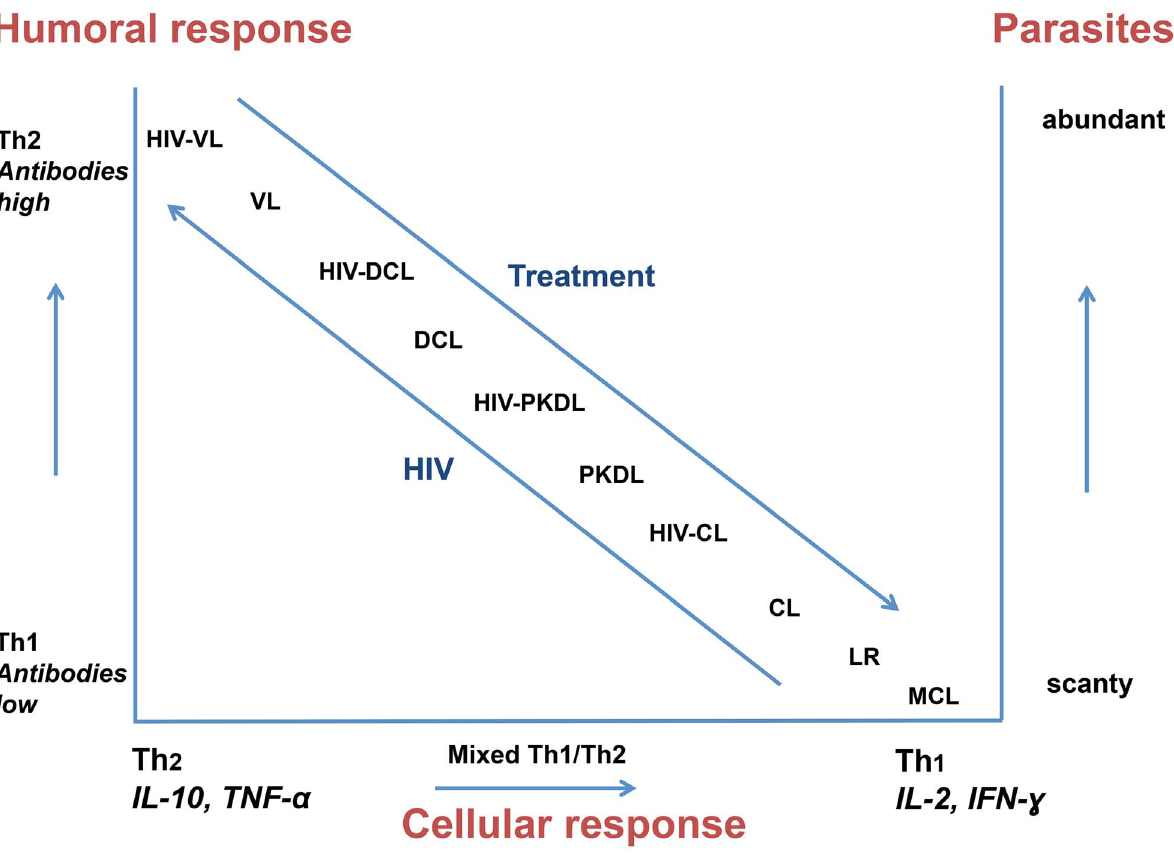
Figure 2. A simplified, theoretical presentation of the relationship between Th1 and Th2 responses, and parasite load, with the influence of HIV and antileishmanial and antiretroviral treatment on cutaneous leishmaniasis (CL), post-kala-azar dermal leishmaniasis (PKDL), diffuse cutaneous leishmaniasis (DCL) and visceral leishmaniasis (VL). The Th17 response is not shown but is similar in polarity to the Th1 response. Mucocutaneous leishmaniasis (MCL) and leishmaniasis recidivans (LR) are indicated as reference points.